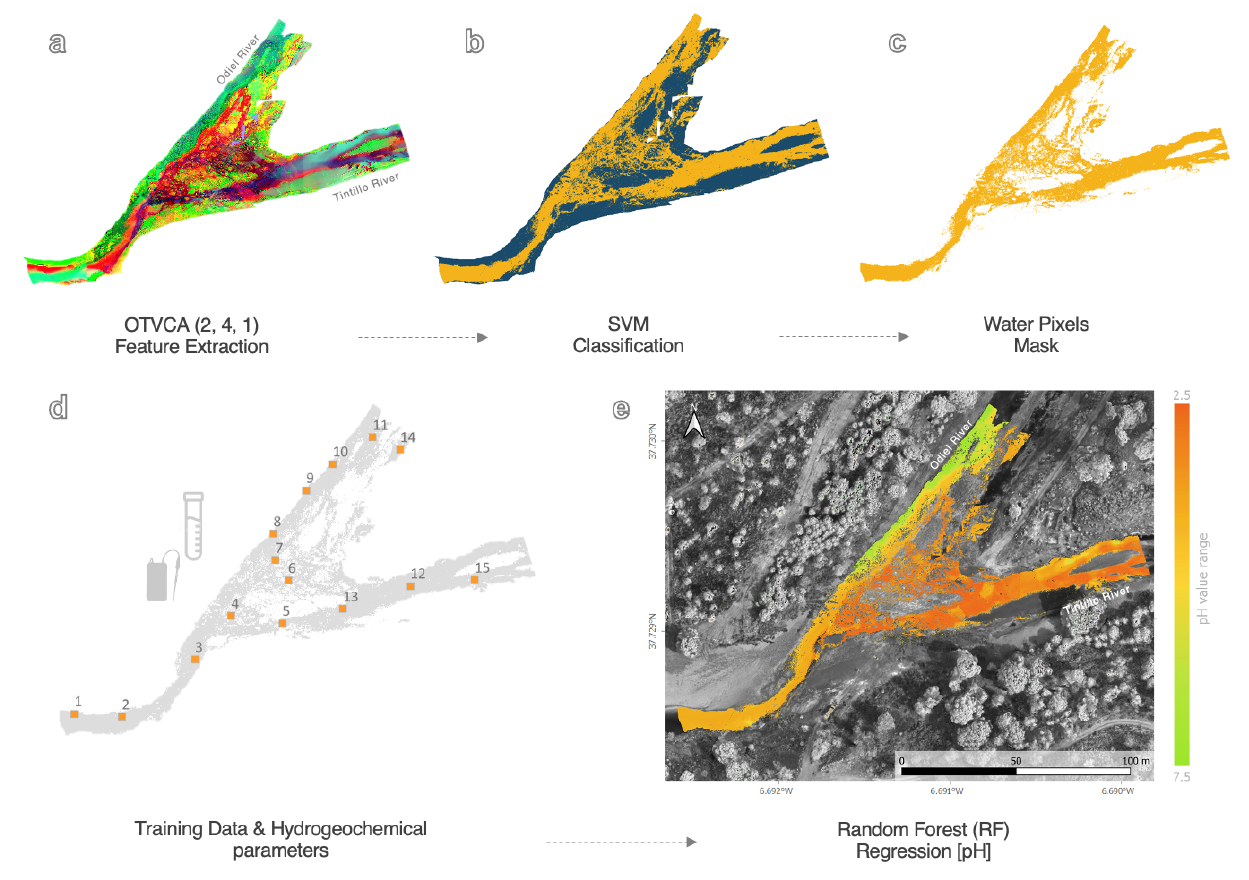
Figure 9. Results of the UAS-hyperspectral data analysis for the water masked pixels. ( a ) Orthogonal Total Variation Component Analysis (OTVCA) feature extraction displaying bands (2,4,1). ( b ) Support Vector Machine (SVM) classification for extracting water pixels belonging to the river flow path and sediment borders. ( c ) Water mask (HSI mosaic was cropped and OTVCA was reapplied). ( d ) Training data preparation (georeferenced ROIs over ground-samples and water parameter allocation). ( e ) Random forest (RF) regression resultant map displaying the pH value